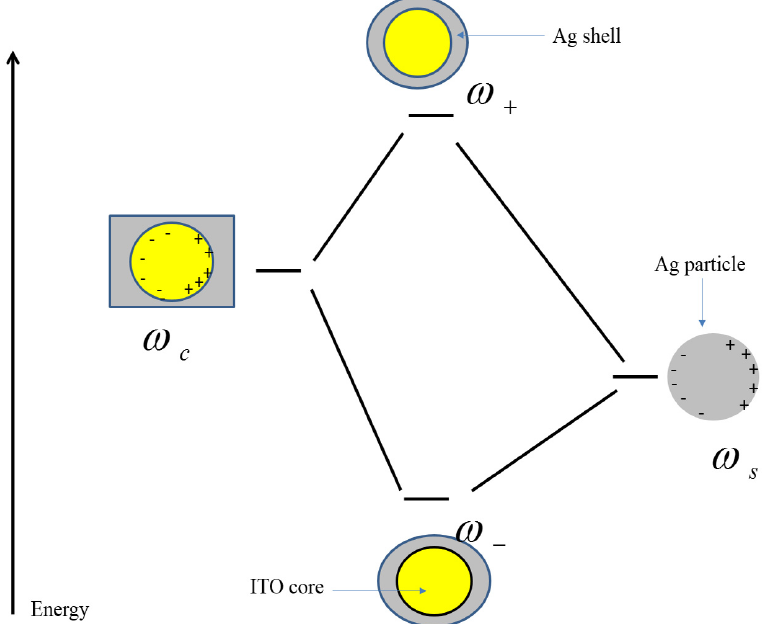
Figure 5. Plasmon hybridization in metallic nanoshells consisting of bonding and antibonding frequencies that are hybridized frequencies of sphere and cavity